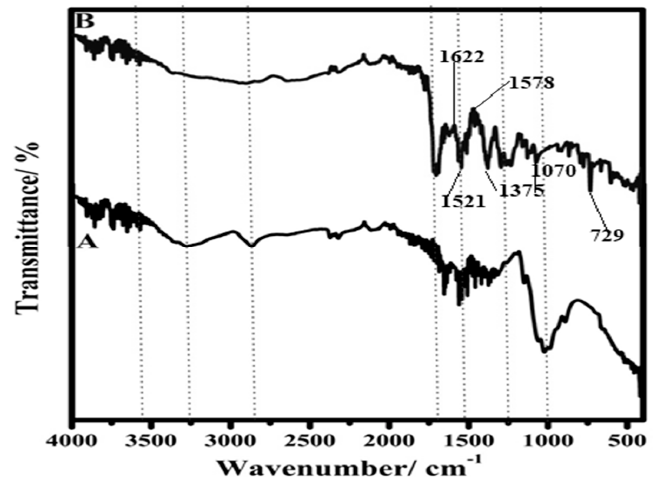
Figure 3. FTIR spectra of ( A ), chitosan and ( B )Zn-BTC@CS.